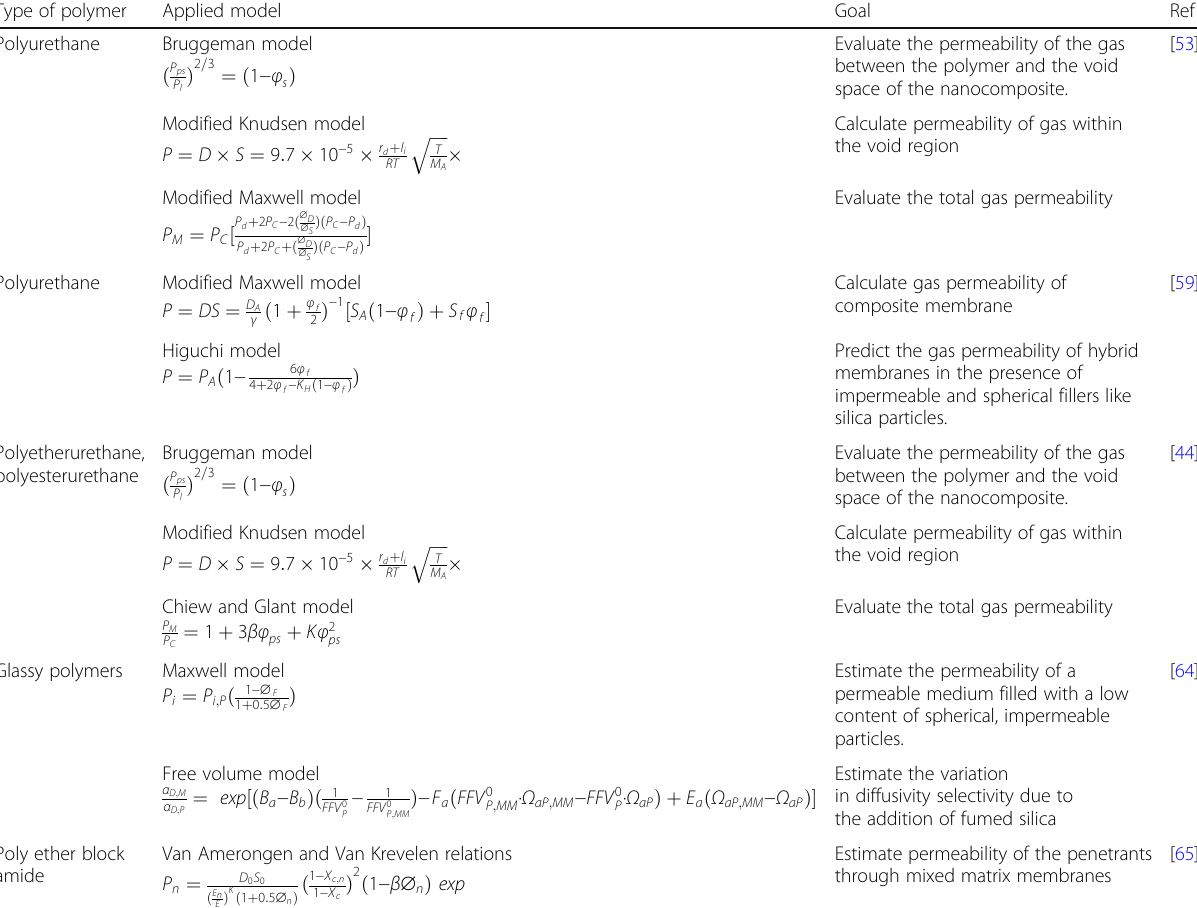
Table 6 Applied models for predicting permeability of mixed matrix membranes containing non-porous silica Type of polymer Applied model